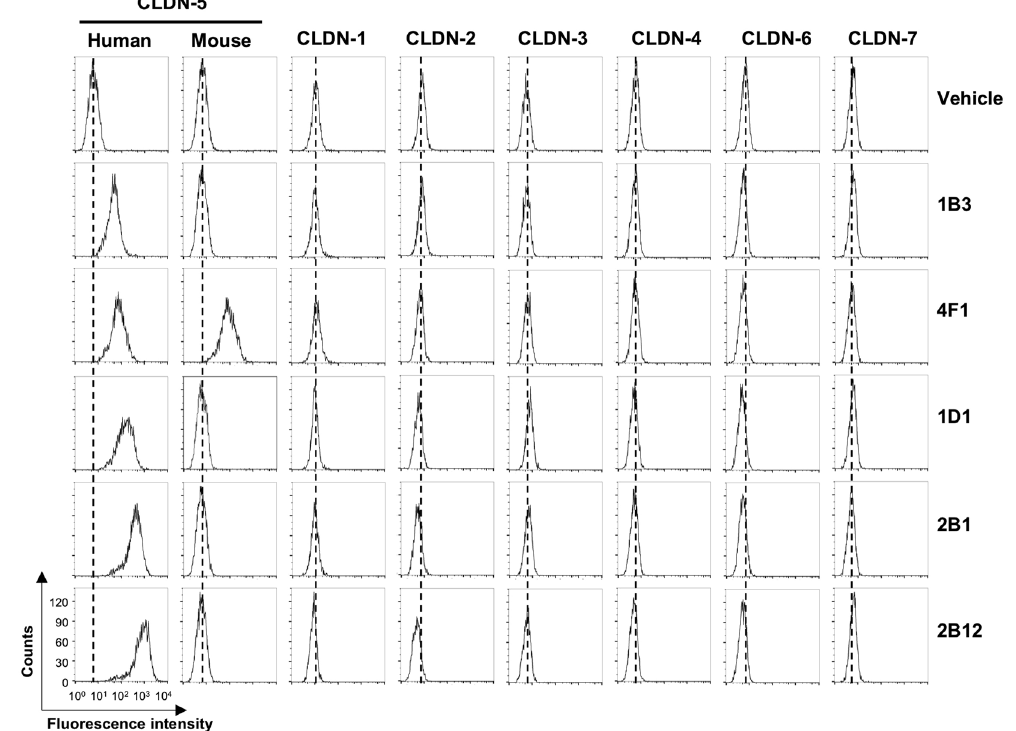
Figure 3. Binding of anti-CLDN-5 ECR mAbs to CLDN–expressing cells. HT-1080 cells expressing CLDNs were treated with vehicle (PBS) or 5 µ g/mL of anti-CLDN-5 ECR mAbs. After fluorescein-labeled secondary antibody treatment, cells were analyzed by flow